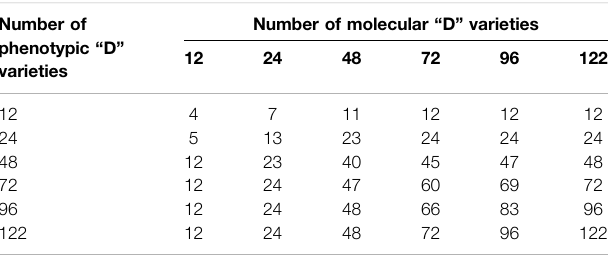
TABLE 5 | Comparisons of distinctness decisions made by using either morphological or molecular distances. Number of phenotypic “ D